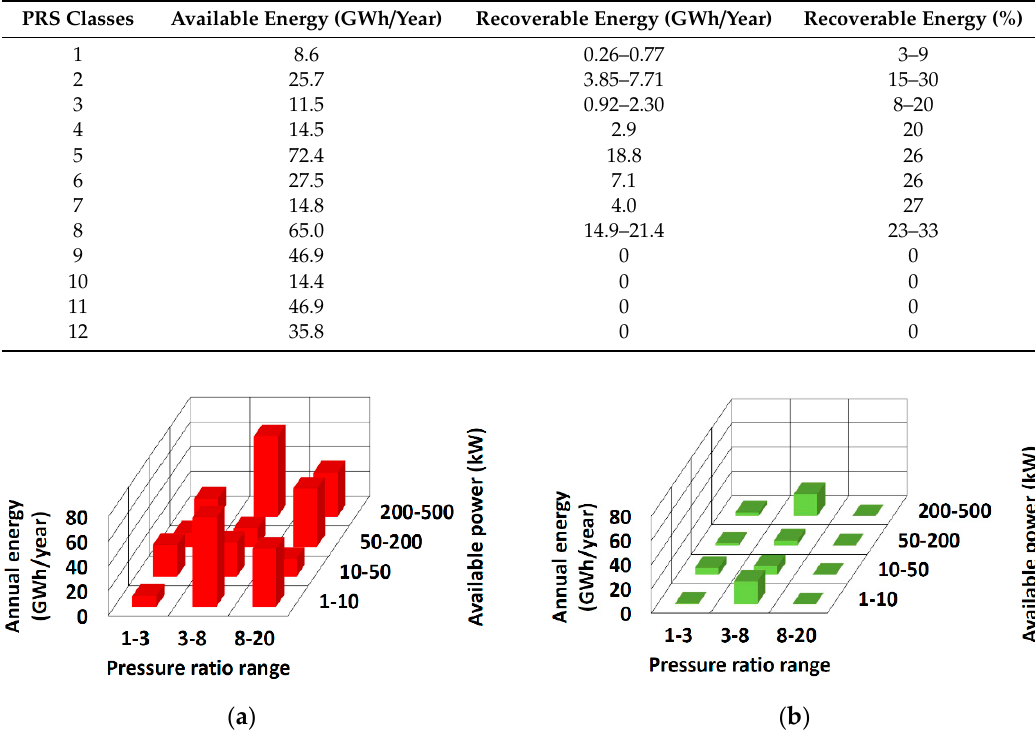
Figure 12. ( a ) Annual available energy and ( b ) annual recoverable energy from the 9000 pressure reduction stations, part of the sample and allocated to the corresponding classes (pressure ratio and available